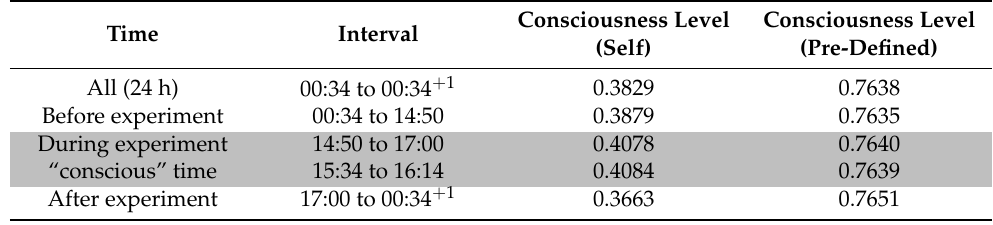
Figure 7. Estimated consciousness level for patient GR. The x-axis represents the recording times, while the y-axis displays the estimated consciousness levels. A value of 0 corresponds to unconscious- ness and a value of 1 means that the patient is conscious. The experiment was performed between 14:50 and 17:00 (dashed lines). The dotted lines at 15:34 and 16:14 delimit ∆ t , the time during which the experimenter reported that the patient was correctly answering the questions he was asked. The values at these times were definitely higher than the values the rest of the time. Table 1. Average estimated consciousness level for patient GR during different time frames using (1) soft-clustering and (2) pre-defined clustering